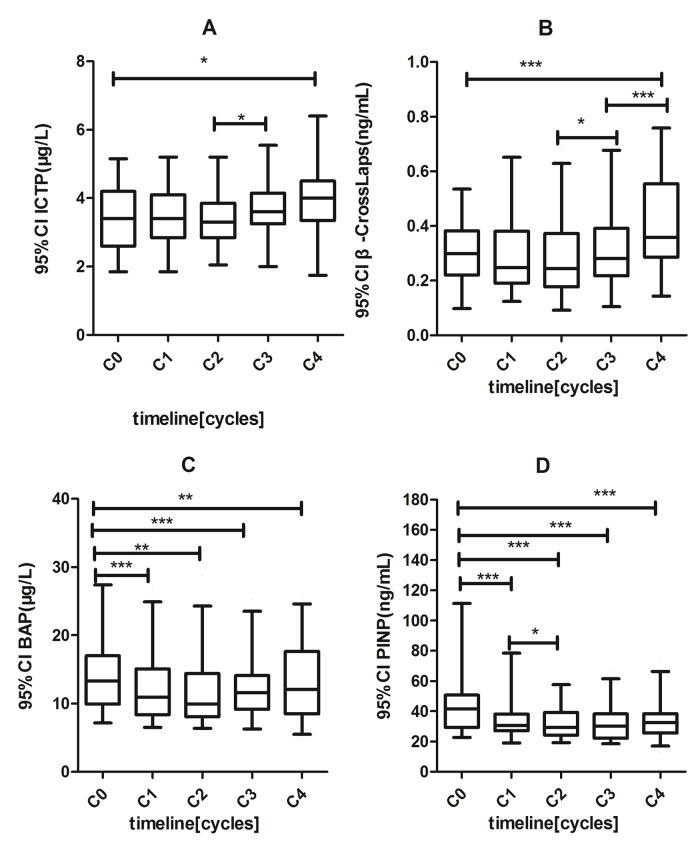
Changes of serum bone turnover markers levels under different cycles of chemotherapy in pre-menopausal breast cancers.(*) p<0.05; (**) p<0.01; (***)p < 0.001. C0: the day of initial diagnosis; C1–C4: 24 hours after the first, second, third. Fourth cycle of chemotherapy.